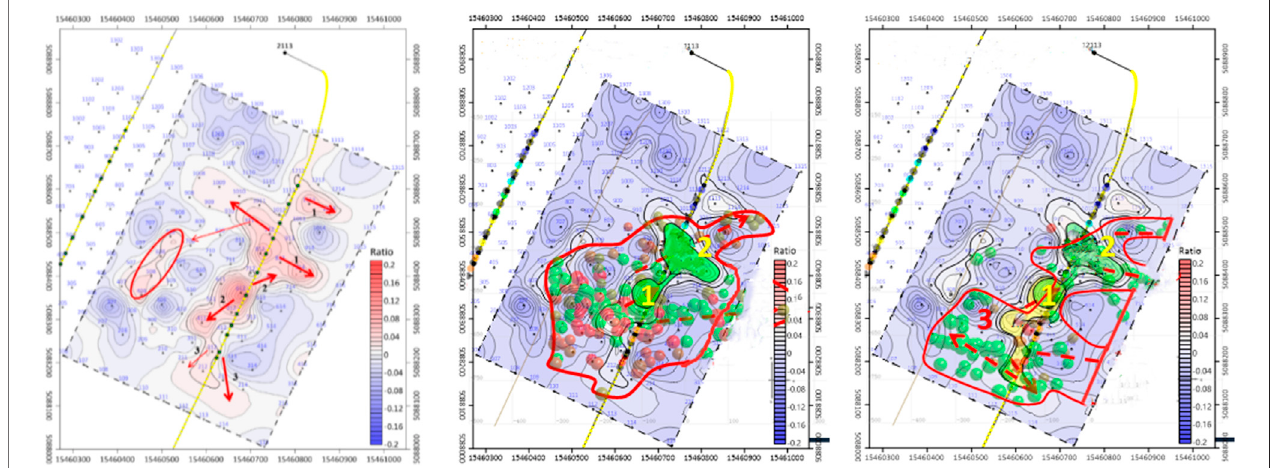
FIGURE 9 | Electromagnetic monitoringof fracturing fl uid migration direction in M3 well (left) , comprehensive analysis oftemporary plugging of old fractures in the M3 well (middle) , and comprehensive analysis results of the fi rst temporary plugging in well M3 (right) .